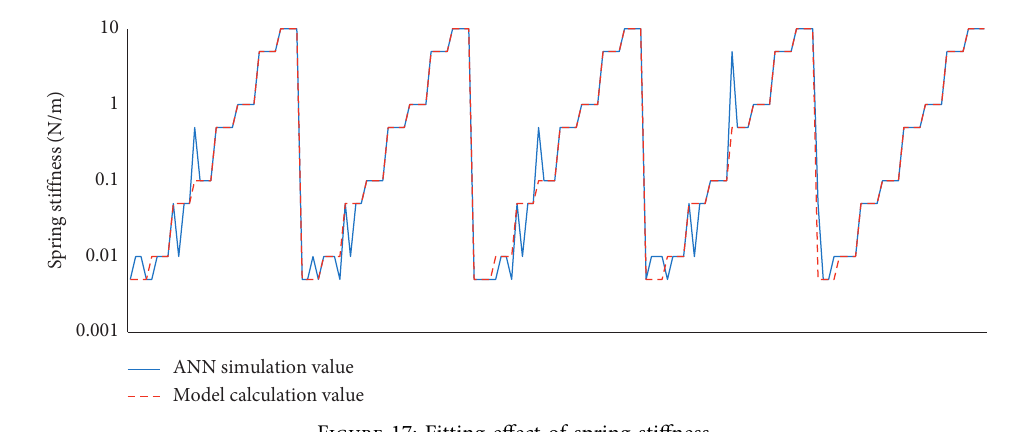
Figure 17: Fitting effect of spring stiffness.